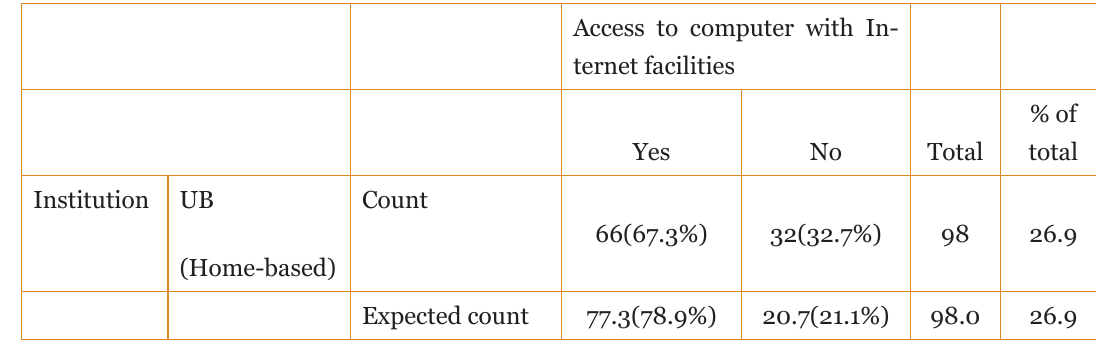
Institution and Access to Computer with Internet facilities